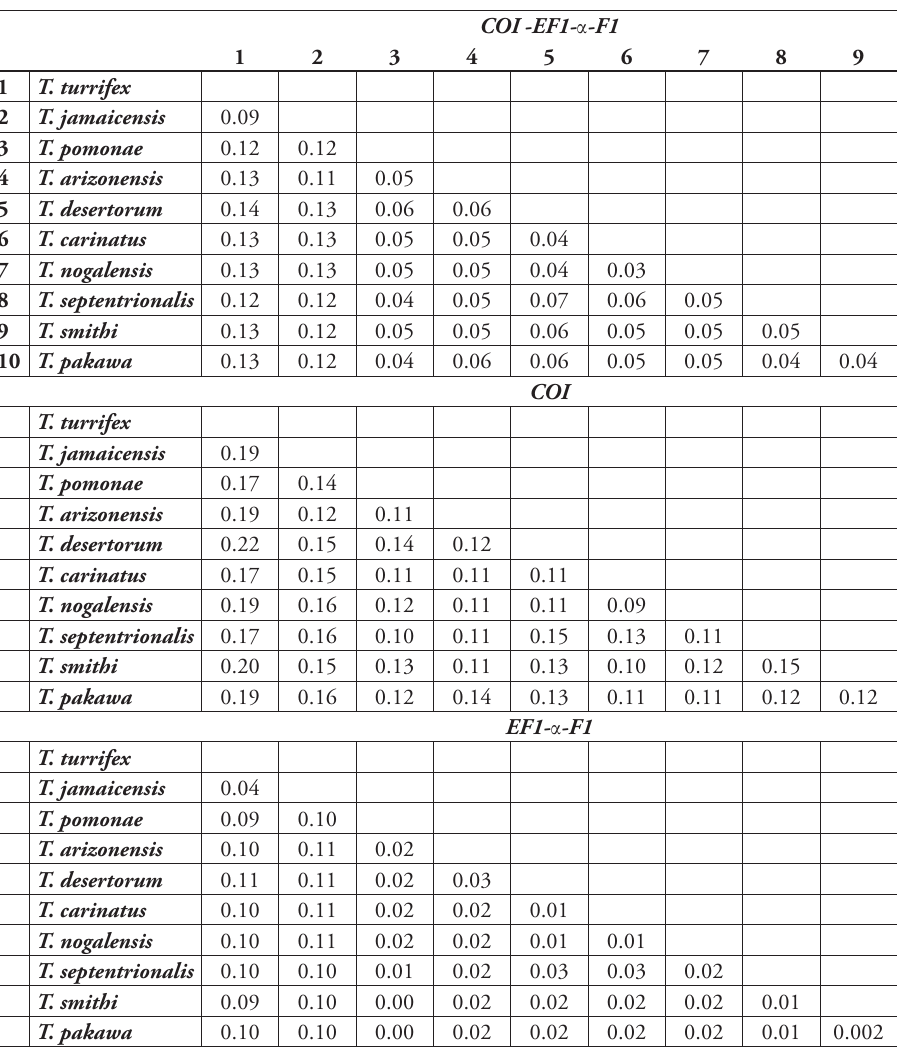
Table 4. Genetic distances (for COI and EF1- α -F1 marker sequences) between North American species of Trachymyrmex including T. pakawa . The three datasets are: A) concatenated sequences, COI and EF1- α -F1 ; B) COI ; C) EF1- α -F1